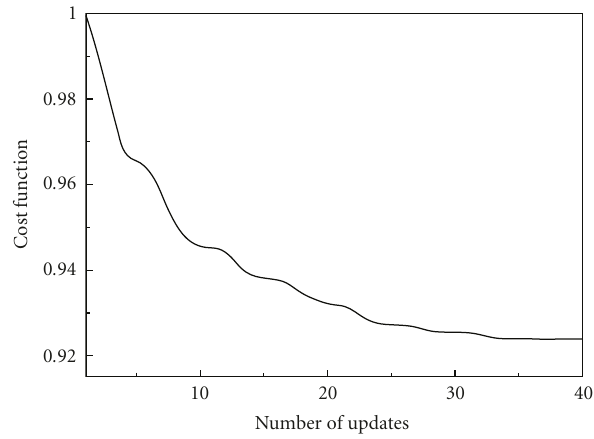
Figure 11: Cost function result on Airplane image blurred by the PSF in Figure 10(a).